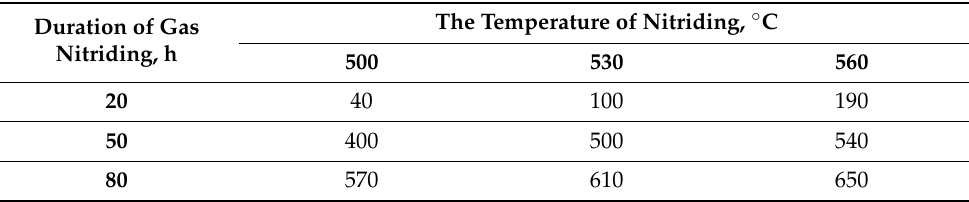
The Temperature of Nitriding, ◦